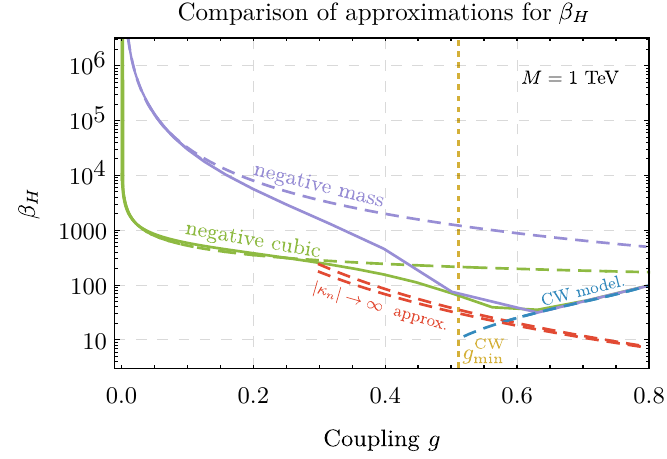
Figure 5 . Evolution of β H as a function of the gauge coupling g for a temperature-independent negative mass-squared ( violet ) or cubic ( light green ) with m 0 /M = 10 − 4 ( δ 0 /M = 10 − 4 ) . Here we clearly see the transition from the scaling behavior at small g , cf. eq. (3.24) ( dashed ), back to the radiative CW model (shown in blue ) at large gauge coupling using the fully numerical results shown as solid curves. For completeness we also show the departure from the conformal behavior in red . The boundary of the supercooling window for the CW model is indicated by the gold dashed vertical